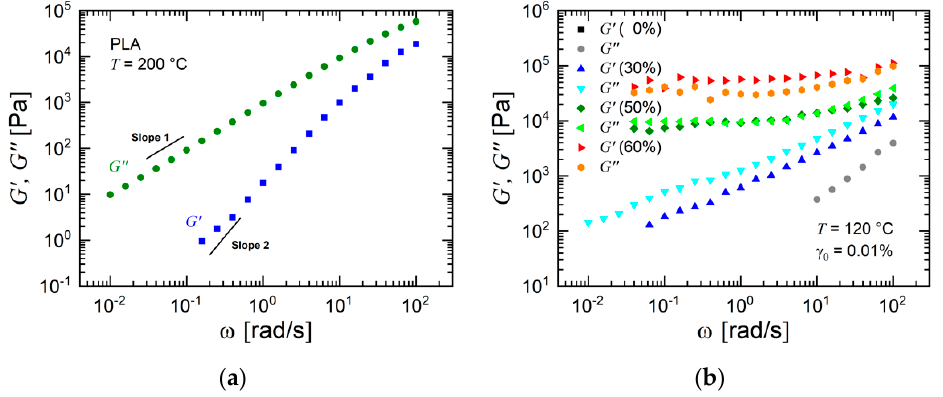
Figure 9. Storage modulus G ′ and loss modulus G ″ of ( a ) polylactide and ( b ) selected feedstocks as a function of angular frequency ω . The shear amplitude was in the linear range with ( a ) γ 0 = 5% and ( b ) γ 0 = 0.01%. In ( a ), the slopes indicate the terminal behavior of the Maxwell model.